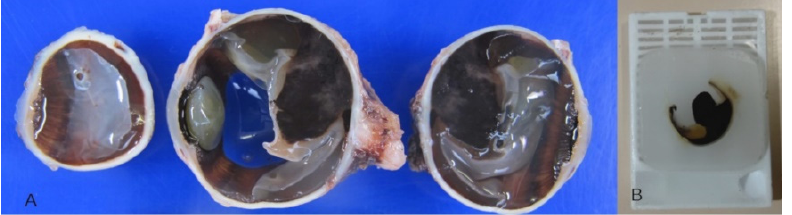
Figure 1. ( A ) Three slices of a formalin fixed e nucleated eyeball with uveal melanoma. ( B ) An eye- ball sample embedded in